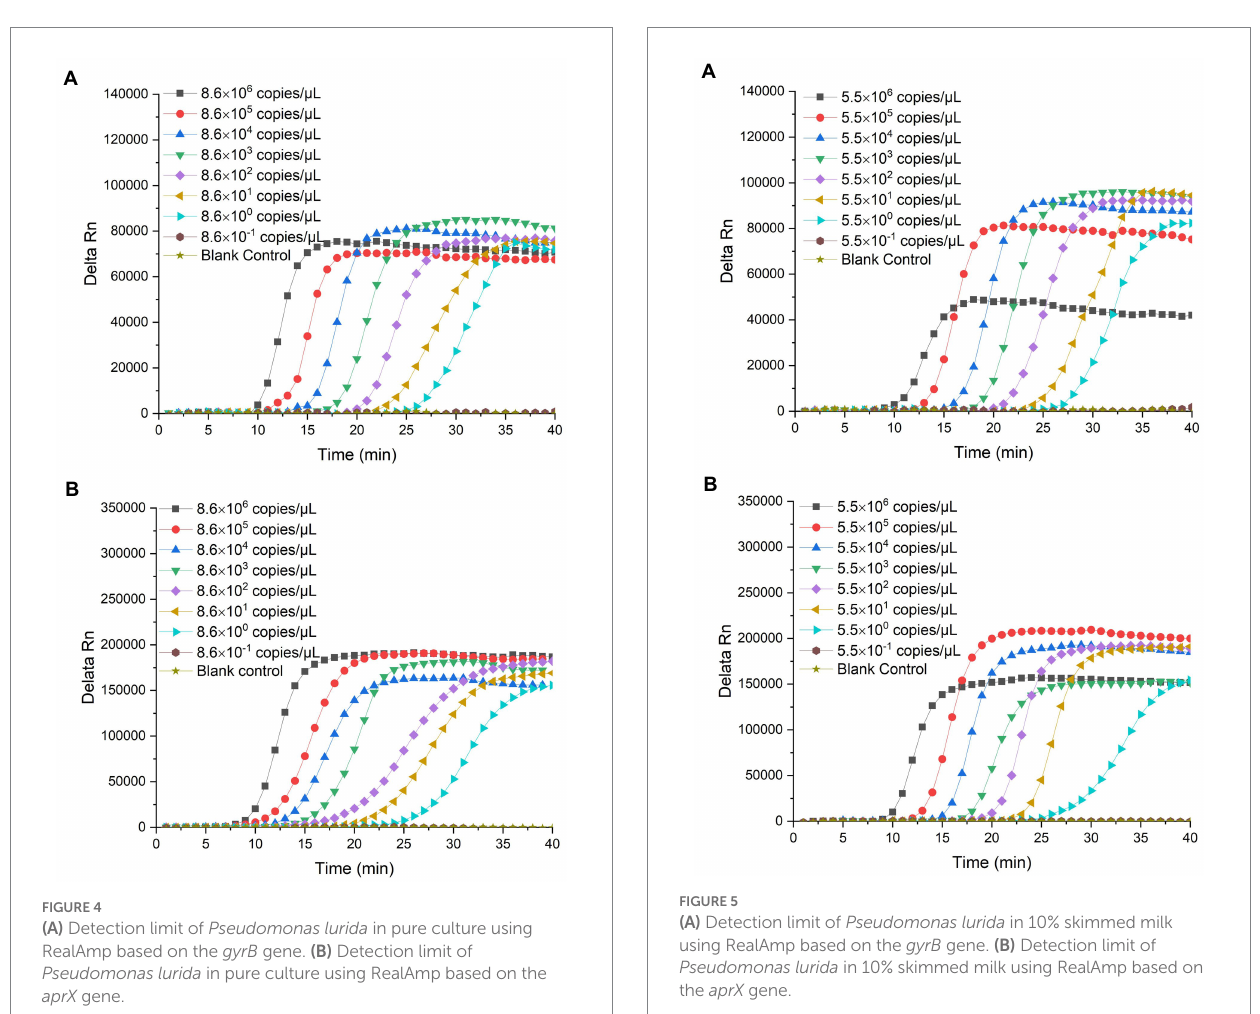
TABLE 1 Reproducibility results of the limit of detection of Pseudomonas lurida in pure culture solutions using RealAmp based on the gyrB and aprX genes.